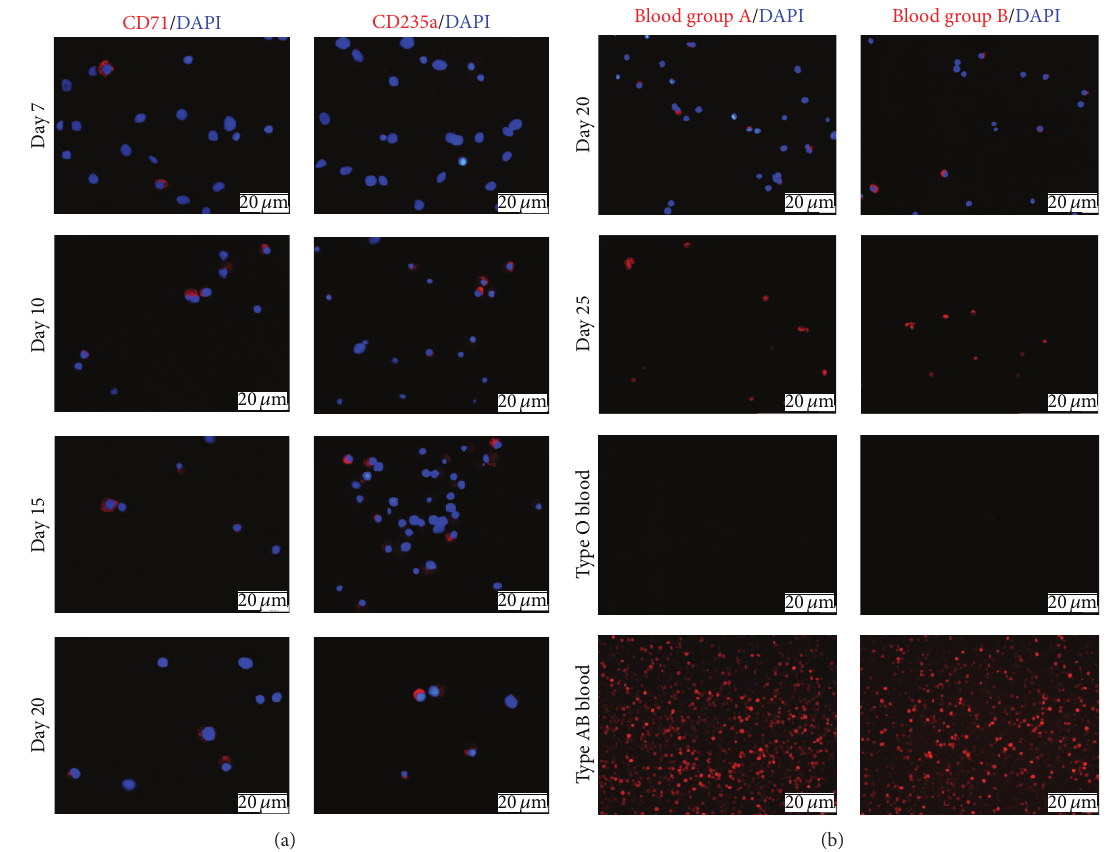
Figure 4: Expression of erythroid markers in hHFMSC-derived erythroid cells. (a) Cell stained with monoclonal antibody against early erythroid progenitor marker CD71 (left) or late erythroid progenitor marker CD235a (right). (b) ABO type characterizations of hHFMSC-derived erythroid cells were detected by staining with monoclonal antibody against A-antigen (left) or B-antigen (right) (original magnification × 200) compared with human type AB blood and type O